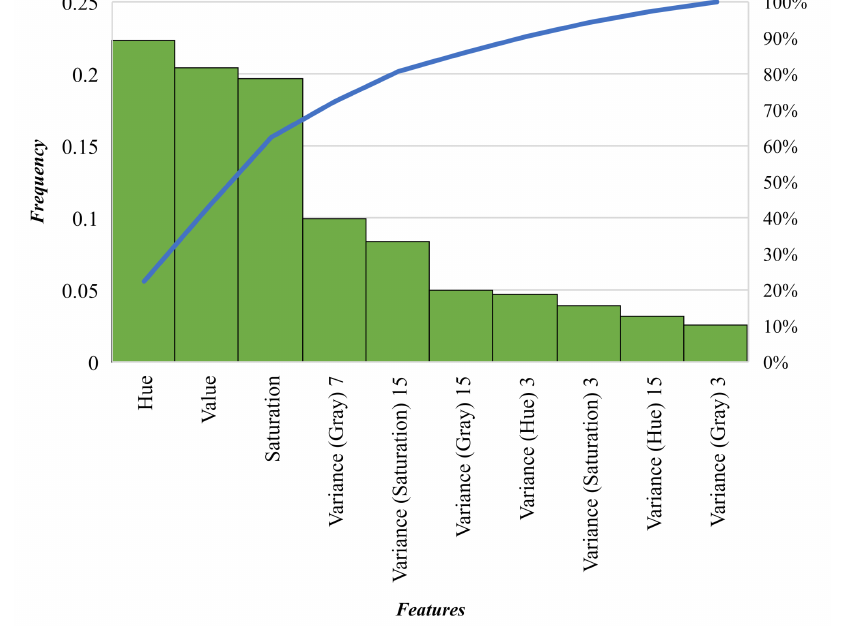
Figure 5. Relevance of each feature for the tuned